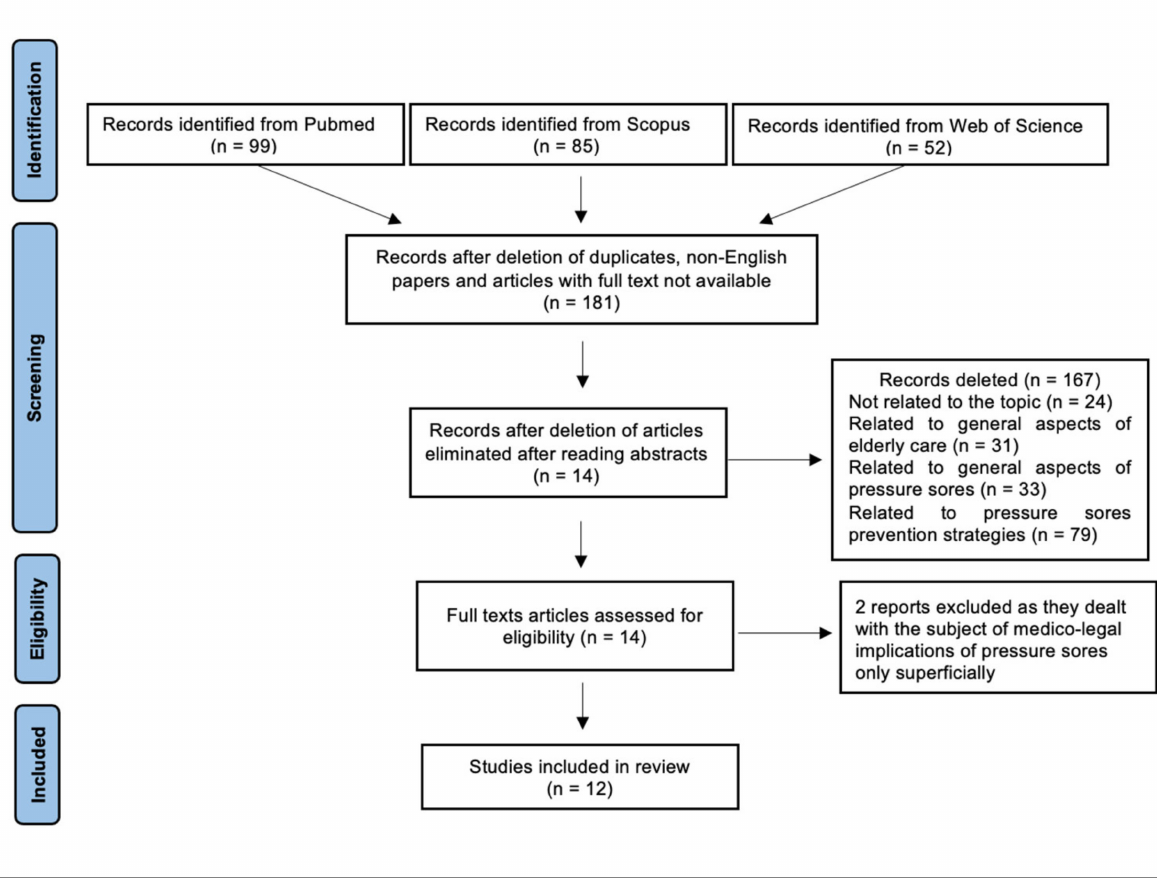
Figure 3. Review search